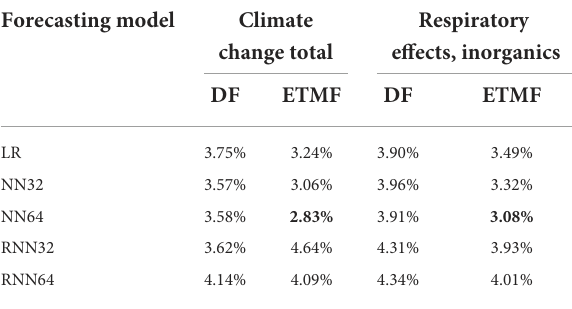
TABLE 3 Average test set performances for the daily SMAPE: Climate change total and Respiratory effects, inorganics categories. For each impact category, the value obtained with the best performing forecasting model are shown in